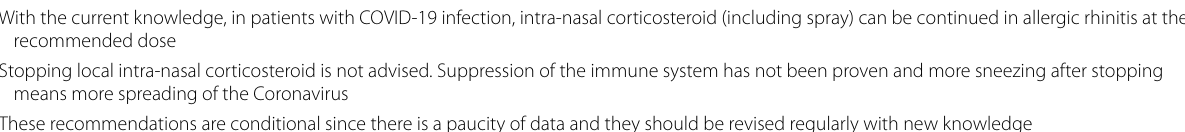
Table 2 Asthma‑specific recommendations from Global Initiative for Asthma (GINA) as reported on GINA website [34] People with asthma should continue all of their inhaled medication, including inhaled corticosteroids, as prescribed by their doctor In acute asthma attacks patients should take a short course of oral corticosteroids if instructed in their asthma action plan or by their healthcare pro- vider, to prevent serious consequences In rare cases, patients with severe asthma might require long-term treatment with oral corticosteroids (OCS) on top of their inhaled medication(s). This treatment should be continued at the lowest possible dose in these patients at risk of severe attacks/exacerbations. Biologic therapies should be used in severe asthma patients who qualify for them, in order to limit the need for OCS as much as possible Nebulizers should, where possible, be avoided for acute attacks due to the increased risk of disseminating COVID-19 (to other patients AND to physi- cians, nurses and other personnel) Pressurized metered dose inhaler (pMDI) via a spacer is the preferred treatment during severe attacks. (Spacers must not be shared at home) While a patient is being treated for a severe attack, their maintenance inhaled asthma treatment should be continued (at home AND in the hospital) Patients with allergic rhinitis should continue to take their nasal corticosteroids, as prescribed by their clinician Routine spirometry testing should be suspended to reduce the risk of viral transmission, and if absolutely necessary, adequate infection control meas- ures should be taken